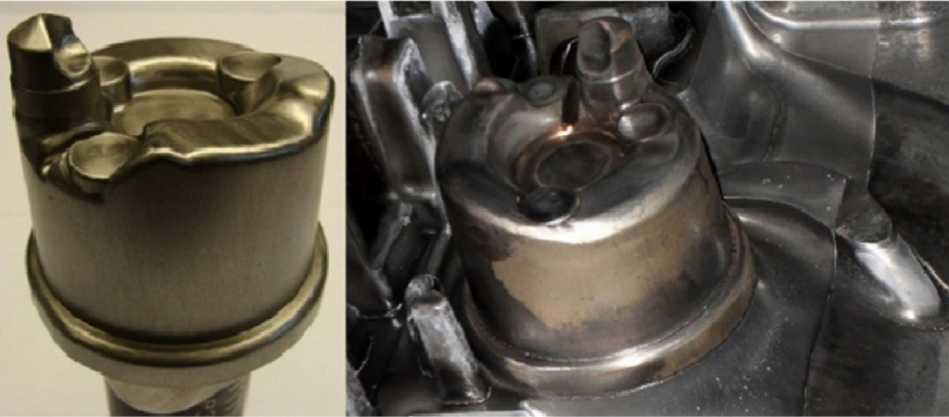
Figure 22. Aluminium die casting: ( left ) The tool insert was made in DIN 1.2709 by L-PBF, after which it was installed as a component in the die